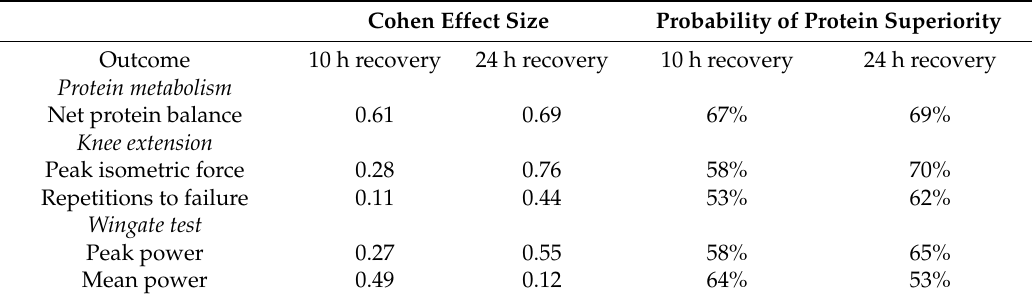
Table 1. Exercise performance recovery effect sizes: REx + CHO vs. REx +